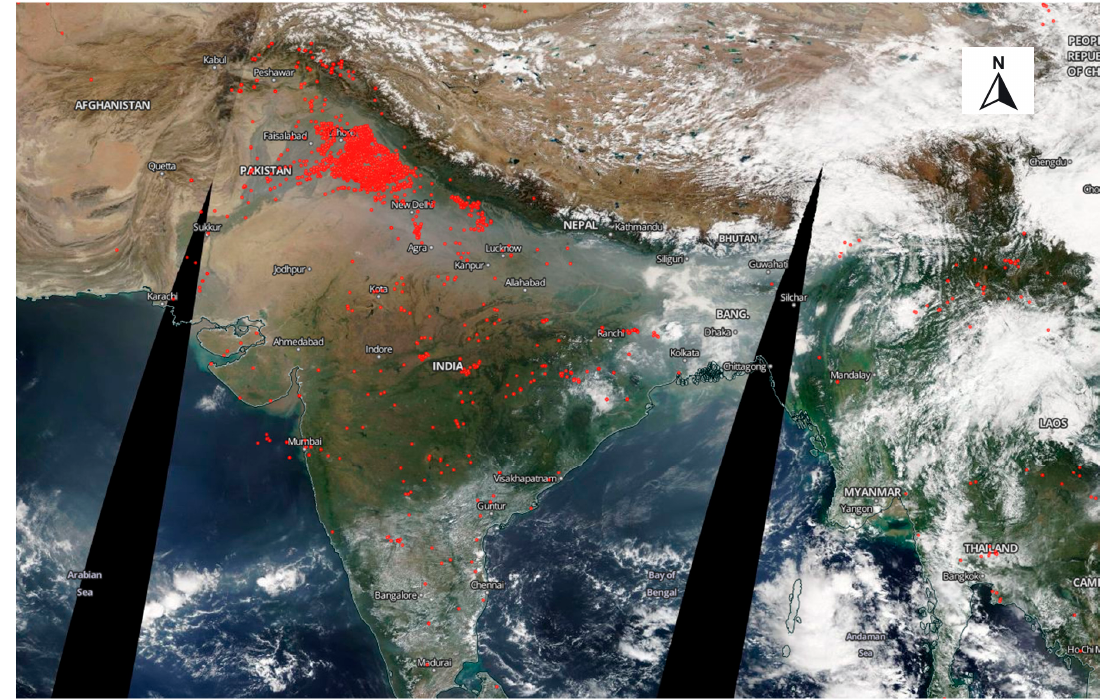
Figure 2. Agricultural fires (in red) occurring in Punjab, India retrieved from the Visible Infrared Imaging Radiometer Suite (VIIRS) on 25 October 2017 during crop residue burning (Source: NASA WorldView).